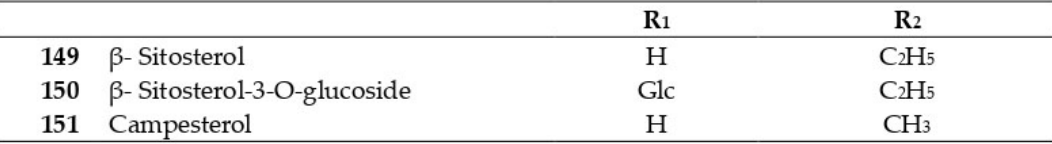
Figure 12. Chemical structure of sterols isolated from genus Salsola.